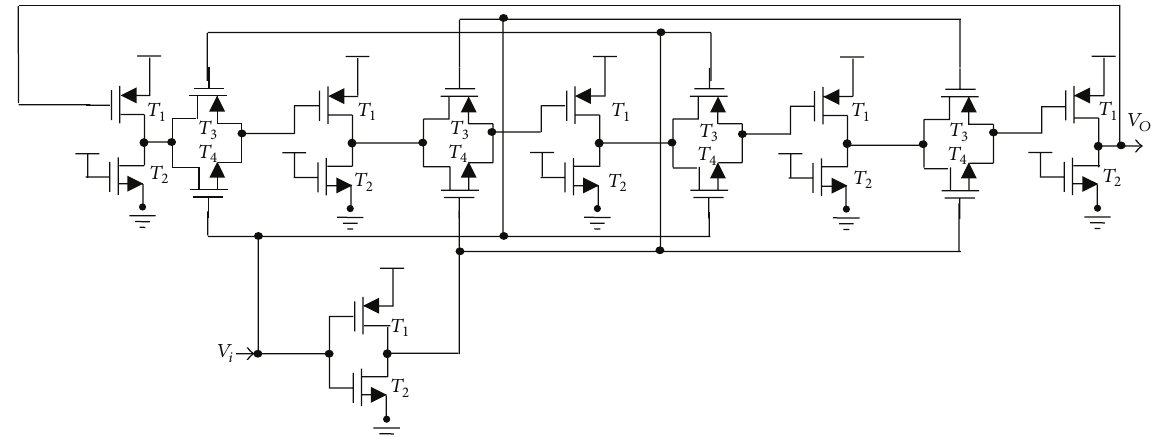
Figure 1: Device level presentation of Current Sink Inverter.